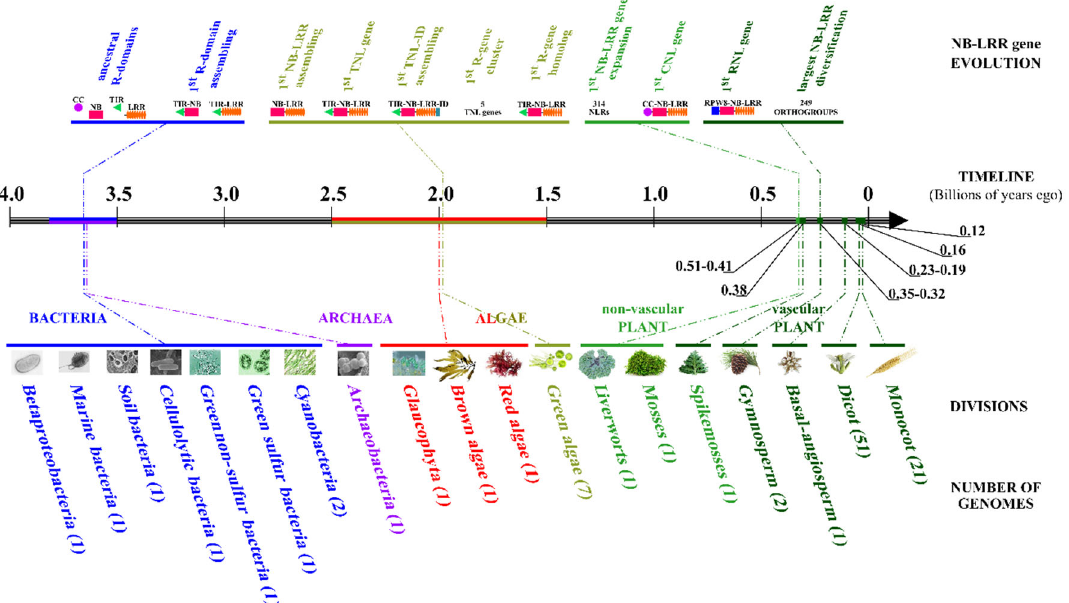
Figure 1. Schematic representation of crucial events which gave rise to NB ‐ LRR gene family in green plants. At the top, the key points of R ‐ gene evolution are connected by dotted lines to timeline and relative taxonomic group. Ancestral R protein domains, first R domain assembling, first NB ‐ LRR association, first TNL gene, first R ‐ gene cluster, first NB ‐ LRR gene expansion, first CNL gene, first R ‐ gene homolog, first RNL association and largest NB ‐ LRR diversification are reported. Finally, the division to which belong the genomes is indicated by pictures.